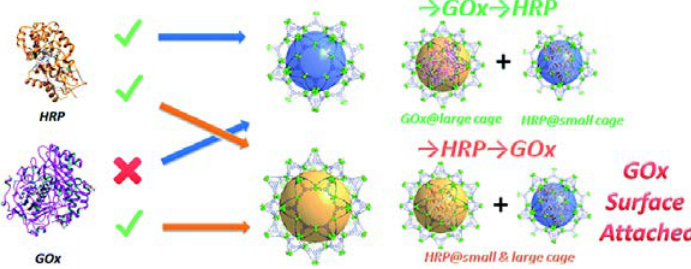
Figure 5. Schematic of the results of the stepwise encapsulation of GOx and HRP with different loading orders in PCN-888. Reproduced from [41] with permission from Royal Society of Chemistry, copyright 2016.